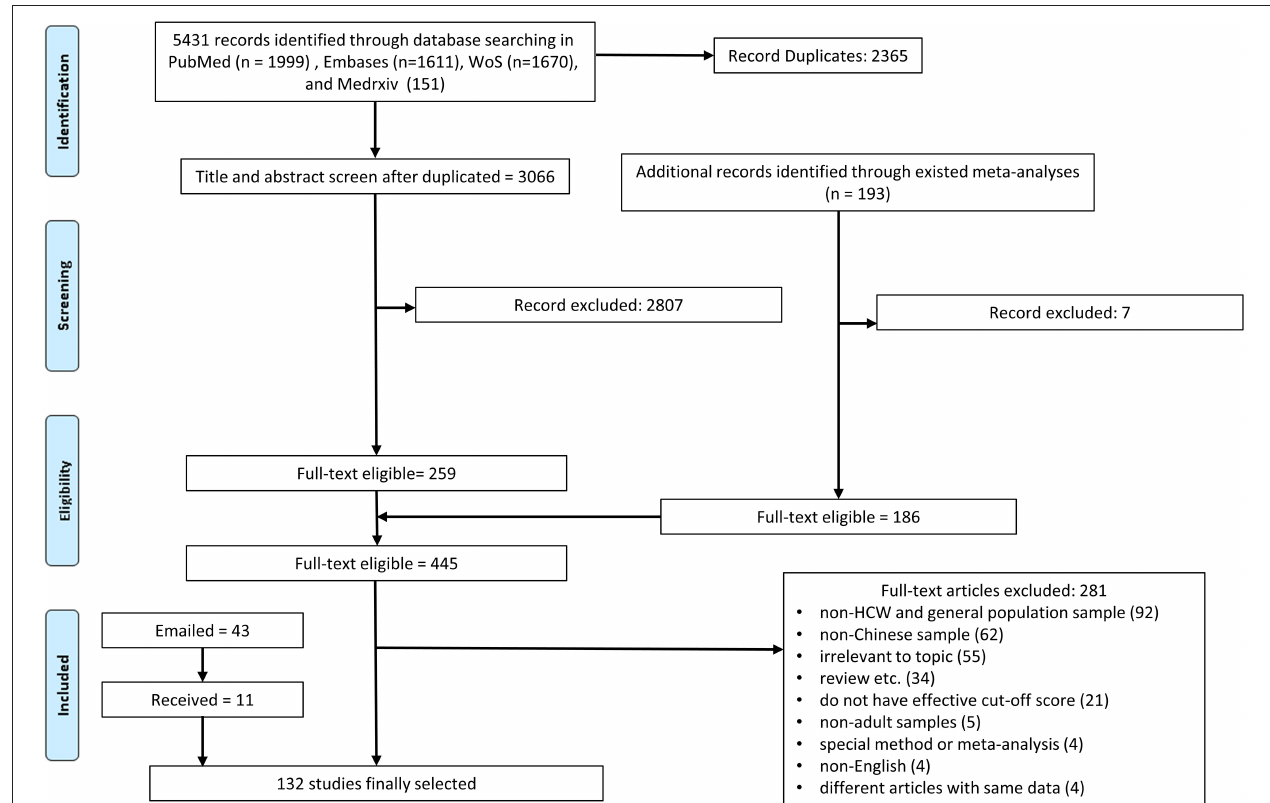
FIGURE 1 | The PRISMA (Preferred Reporting Items for Systematic Reviews and Meta-Analysis) flow